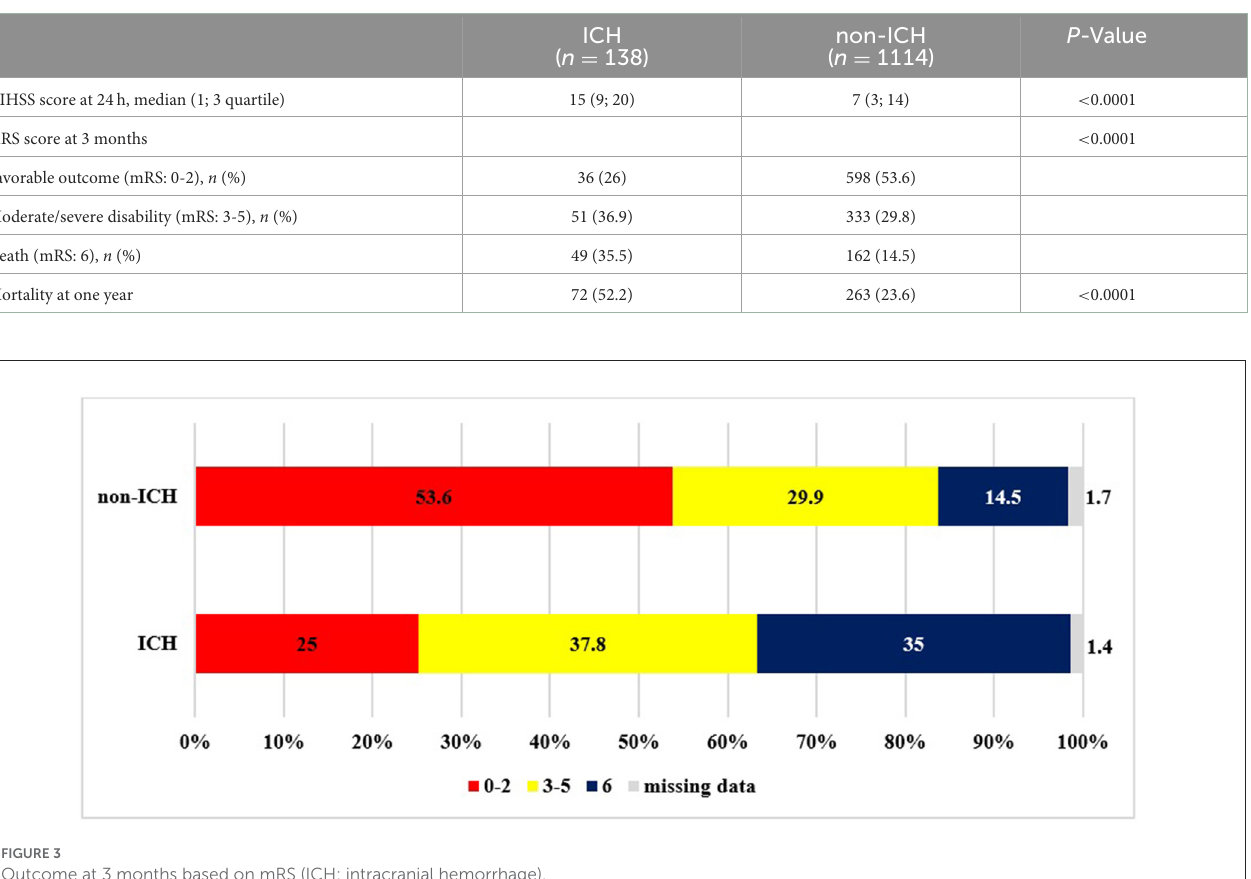
TABLE 2 Clinical outcome of patients with and without post-thrombolysis intracranial hemorrhage.